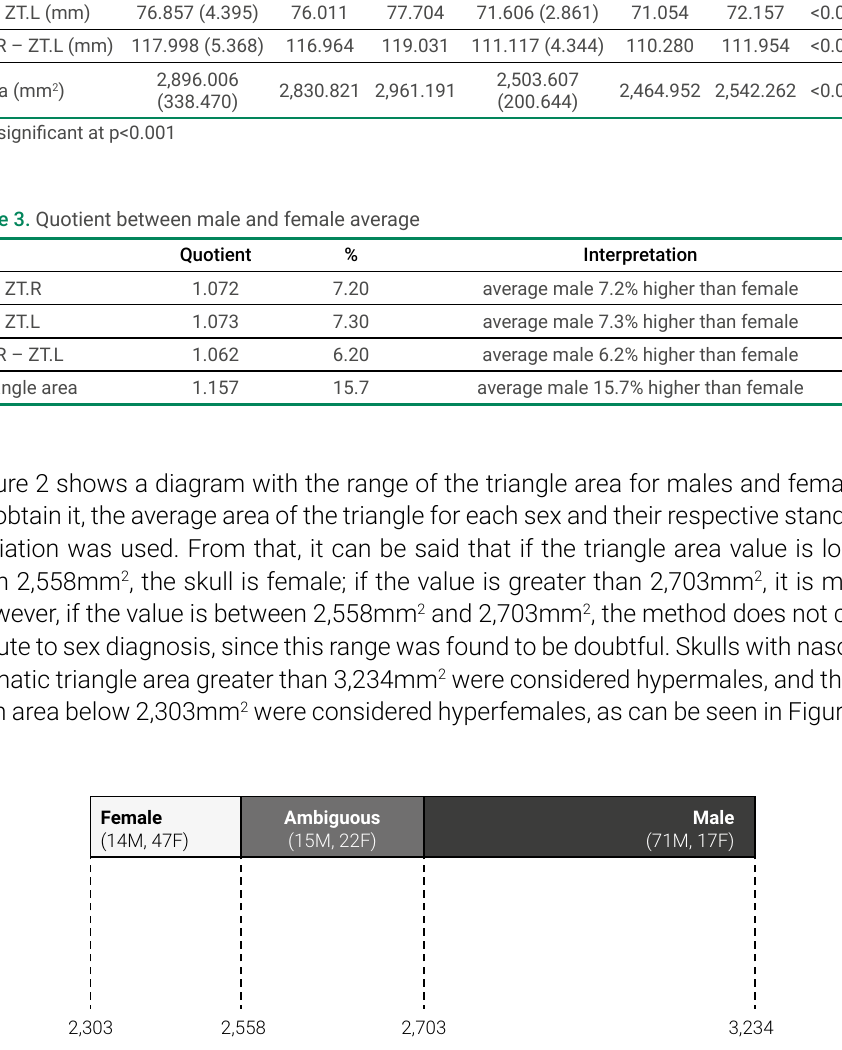
Table 2. Student t-test with average male and female and their minimum and maximum limits Male Female mean (SD) min max mean (SD) min max p